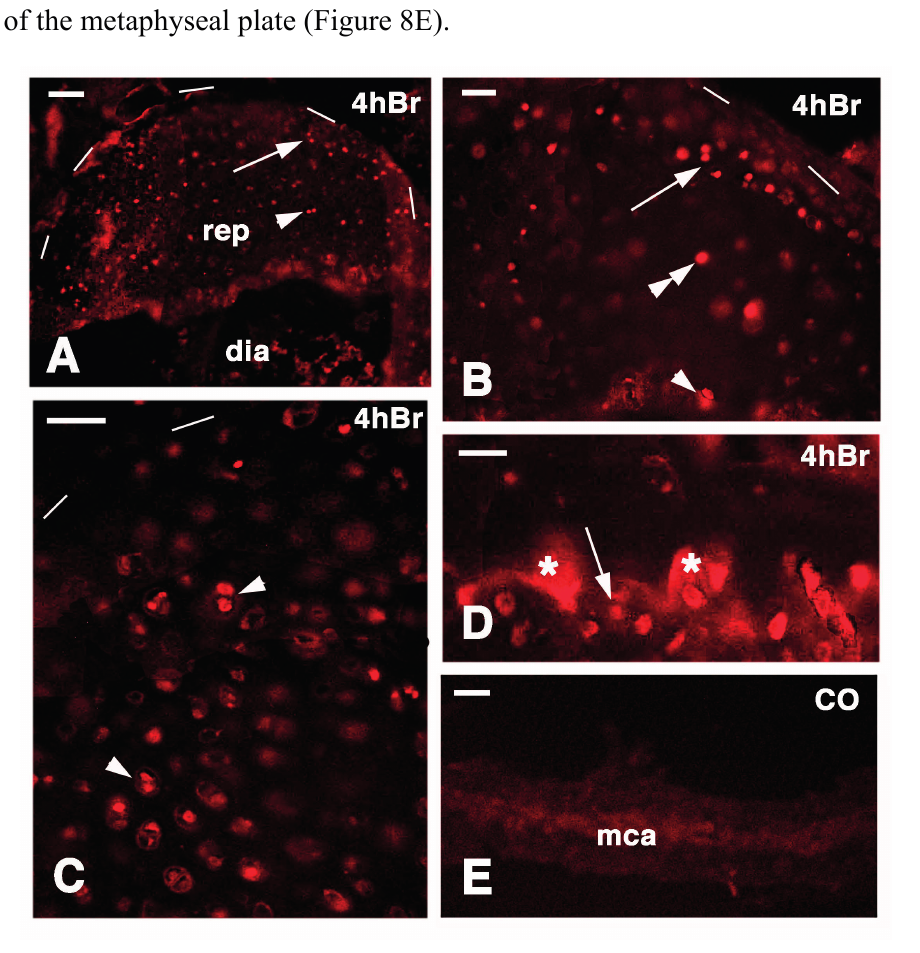
arrowhead), serial metaphyseal cartilage (arrowhead). Bar, 25 µm; ( C ) Detail on the labeled chondroblasts of isogenous groups (arrowheads) of regenerated cartilage. Bar, 25 µm; ( D ) Detail on labeled